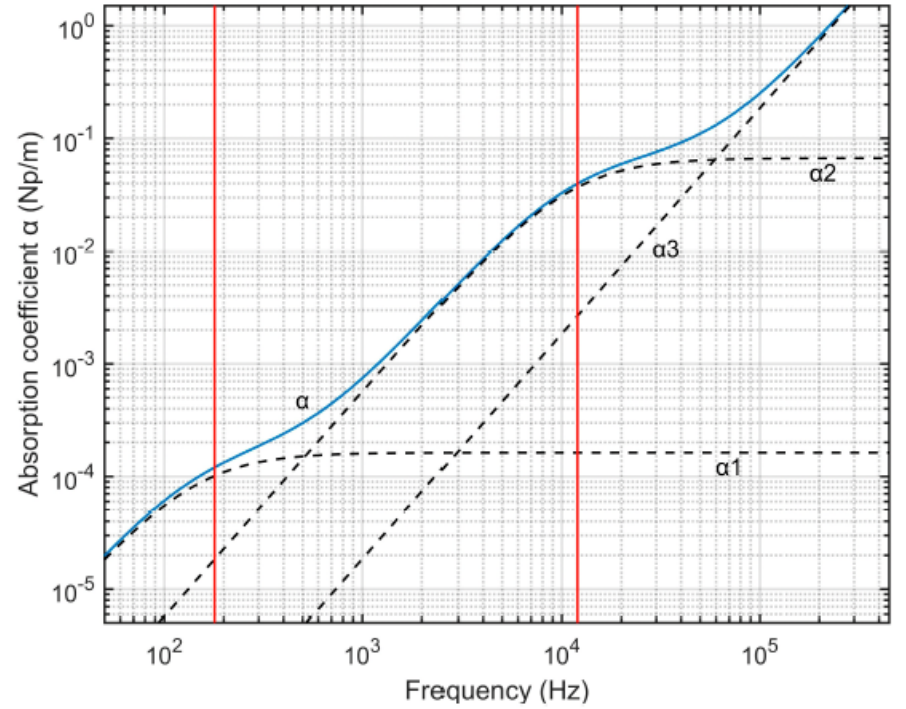
Figure 6. Acoustic attenuation in the atmosphere (Reprinted from ref.